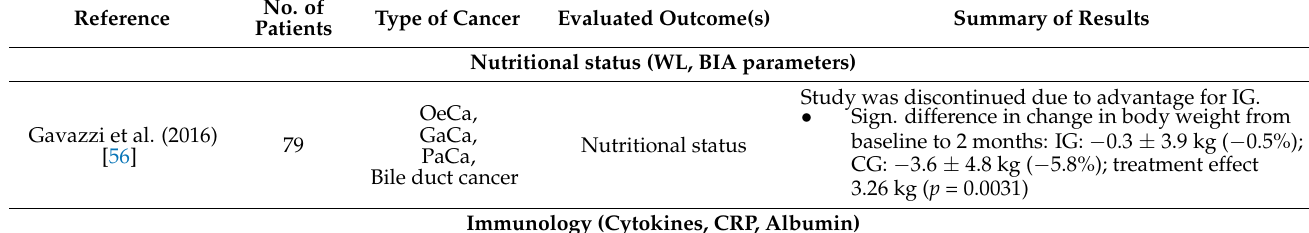
Table 3. Randomized controlled trials of enteral